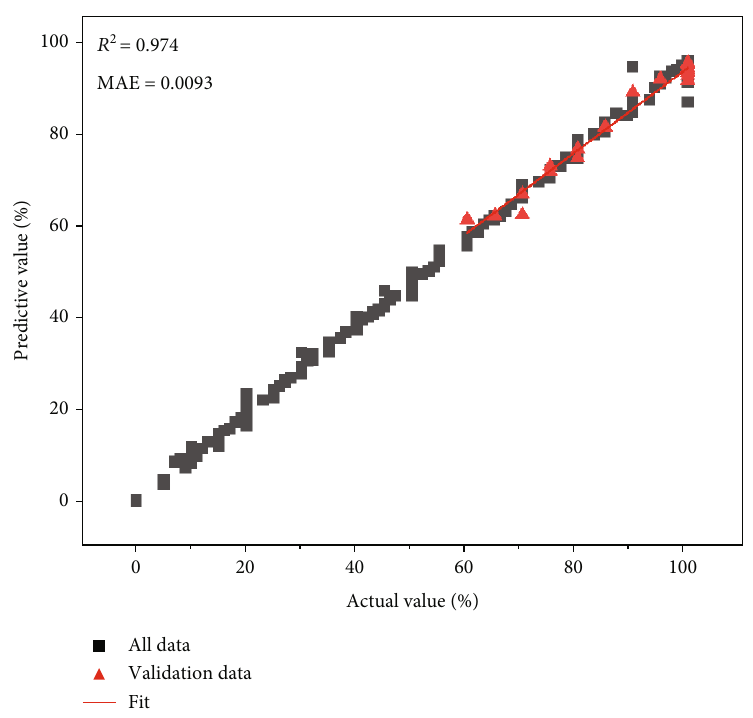
Figure 17: Validation of the model by the improved on-site leakage plugging case. Table 4: Some real cases of fracture leakage plugging in Carboniferous strata in Chepaizi